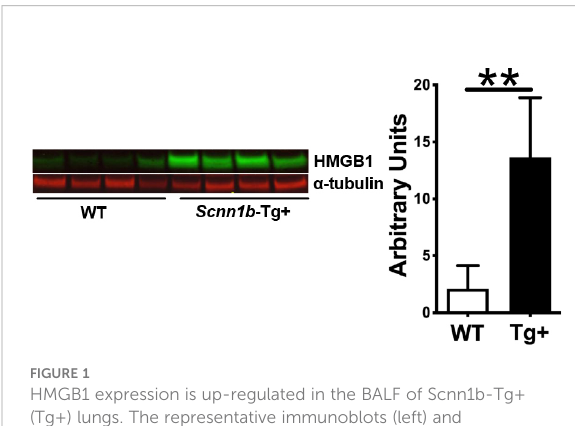
FIGURE 1 HMGB1 expression is up-regulated in the BALF of Scnn1b-Tg+ (Tg+) lungs. The representative immunoblots (left) and corresponding quanti fi cation of the immunoblots (right). Equal volumes of cell-free BALF from WT and Tg+ adult mice (n=4/group) were used. a -tubulin was used as a loading control. Error bars represent Mean ± SEM. One-way ANOVA followed by Tukey ’ s post hoc test was used for the statistical analysis. ** p <